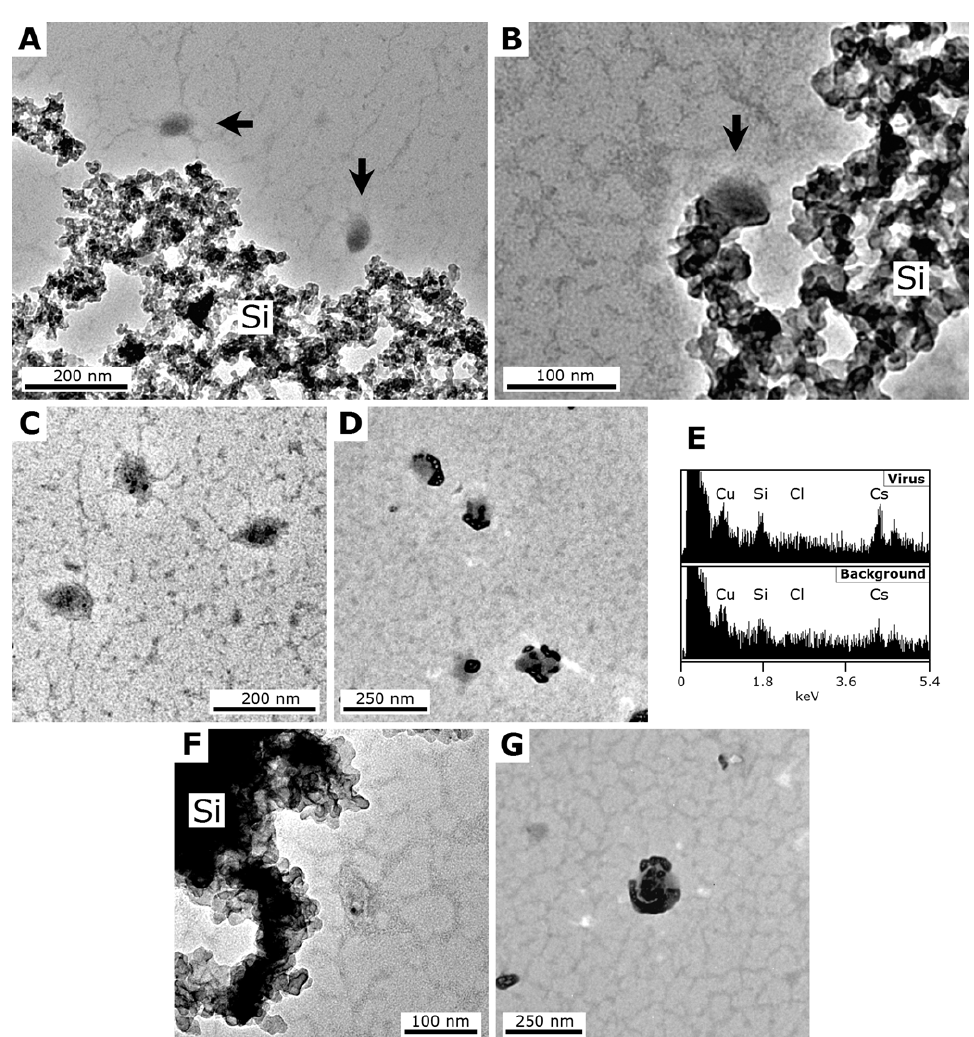
Fig. 3. TEM micrographs showing progressive steps of the experimental fossilisation of TPV1 at a ∼ 320ppmSi silica concentration. (A) 1 week, two TPV1 particles (arrows) near a silica precipitate (Si). (B) 1 month, TPV1 particle (arrow) attached to the silica precipitate (Si). (C) 75days, TPV1 particles with dark nanometric particles within. (D) 75days, unstained grid, TPV1 particles on which a dark precipitate has formed. (E) 75days, EDX spectra obtained on the virions of (D) and on the background, showing Si and Cs signals on the precipitate; the Cl signal comes from buffering medium and the Cu signal comes from the copper grid. (F) 180days, deformed TPV1 particle near a silica precipitate (Si); note the dark particle within. (G) 180days, unstained grid, TPV1 particle covered and filled with a dark precipitate. All TEM micrographs were made at 200kV on grids negatively stained with uranyl acetate, unless otherwise